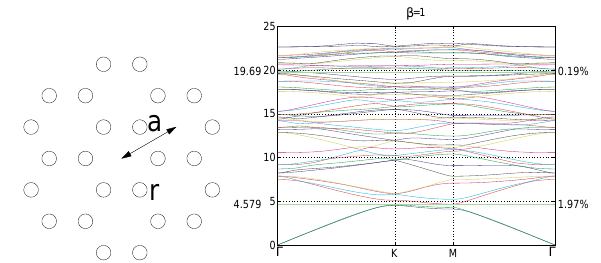
FIG. 9. (Color) Honeycomb lattice and its SOL band gap. In the simulation, we assumed r (cid:3) a (cid:1) 0.24 and k 0 is normalized to 1 (cid:3) a .